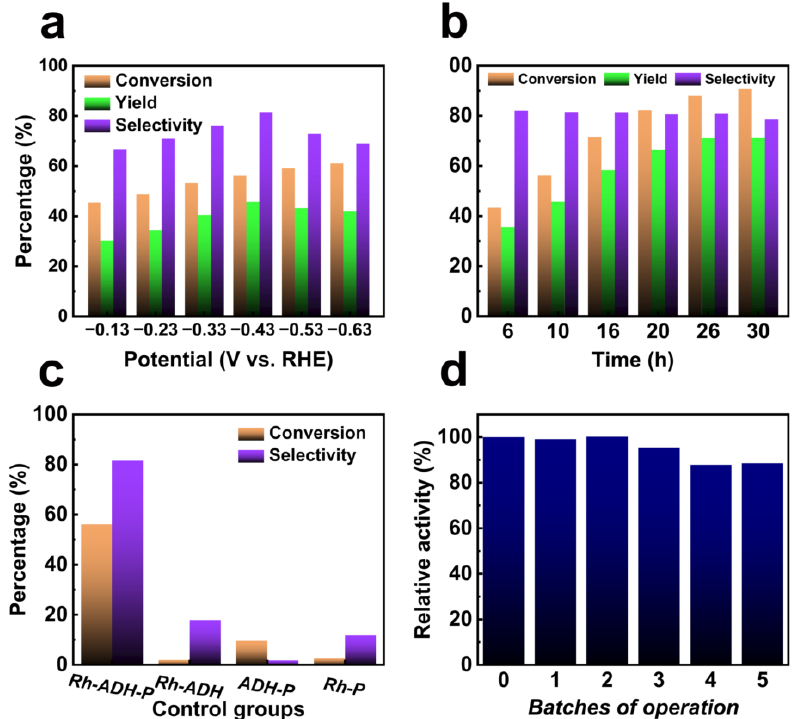
Figure 4. Bio-electrocatalytic reduction of furfural into furfuryl alcohol using the Rh-complex fixed electrode. ( a ) The effect of the applied potentials on furfuryl alcohol production, ( b ) time course of the bio-electrocatalysis furfural transformation at − 0.43 V vs. RHE, ( c ) comparison of the bio-electrocatalytic furfural conversion and the furfuryl alcohol yield with the control groups. Rh-ADH-P: The Rh-complex fixed electrode with ADH and the applied potential, Rh-ADH: The Rh-complex fixed electrode with ADH and no applied potential, ADH-P: Bare amino-modified carbon paper with ADH and the applied potential, Rh-P: The Rh-complex fixed electrode with the applied potential and without ADH, ( d ) stability of the bio-electrocatalytic reduction of furfural into furfuryl alcohol using the recovered Rh-complex fixed electrode.